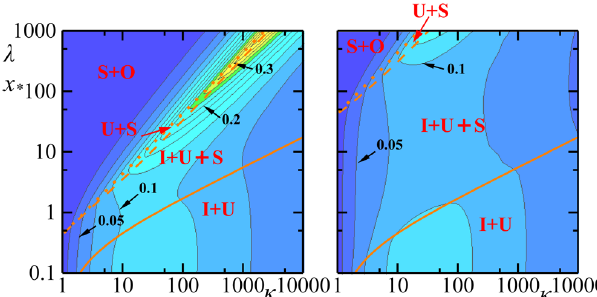
Fig. 6. Contour plots of RBPI ∗ against κ and λ for ε = 1 (left) and 100 (right). Orange solid, dashed, and dotted lines represent the hor- izontal distances for the end point of the I zone ( x iu ∗ ) , the start point of the S zone ( x us ∗ ) , and the start point of the saturation-excess overland flow ( x so ∗ ) , respectively. The red letters indicate which zones are included in the vertical profile at each horizontal point of the sloping soil layer (see Fig.